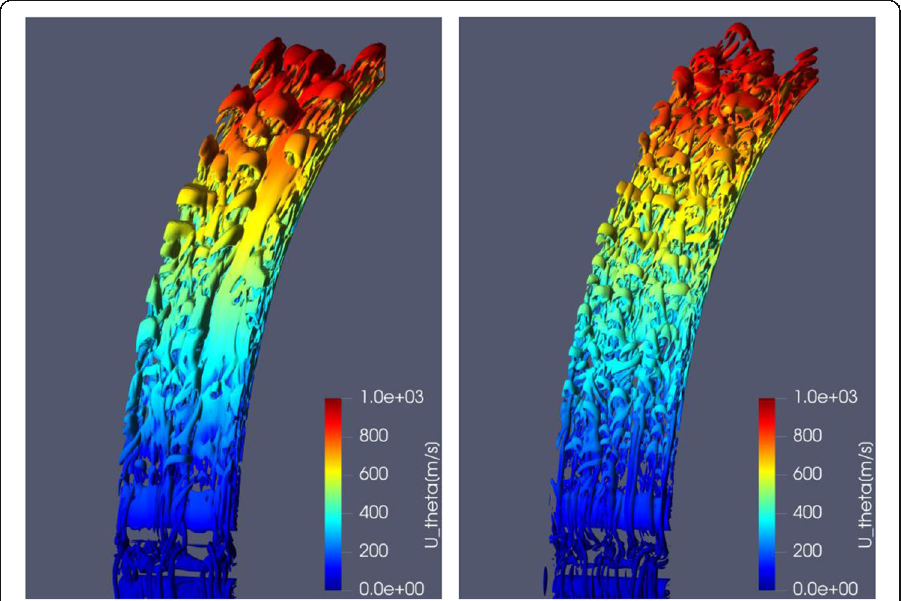
Fig. 11 Isosurface of Q-criterion. Left: (S1, Coarse), Right: (S2, Coarse). The surface is colored according to the magnitude of the circumferential velocity for